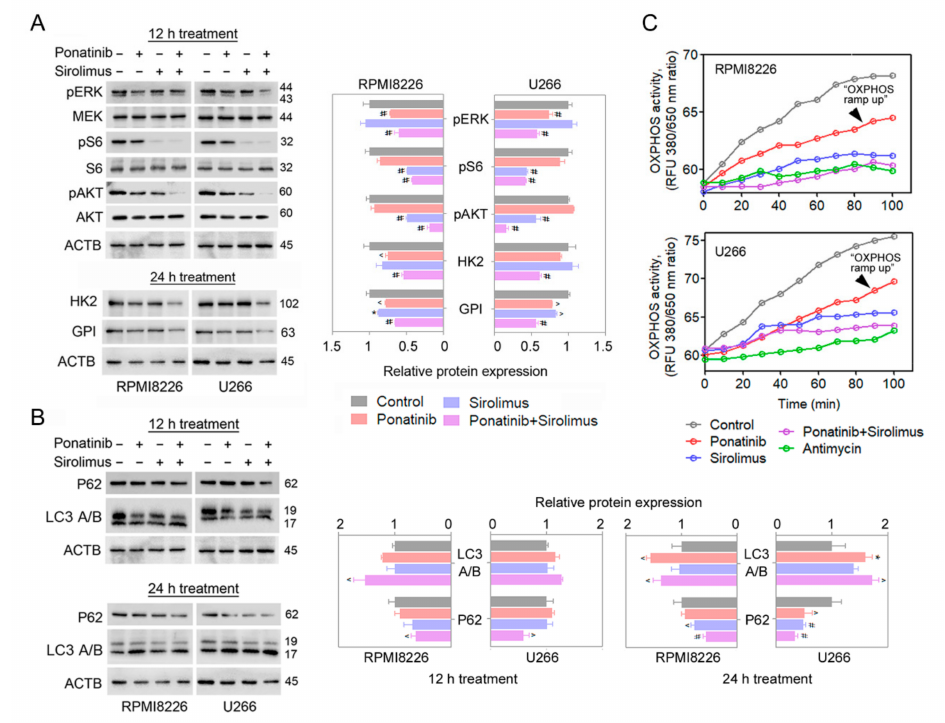
Figure 4. Ponatinib and sirolimus inhibit AKT/mTORC1 pathways and residual oxidative phos- phorylation (OXPHOS) in multiple myeloma cells. ( A ) Ponatinib at 300 nM and/or 150 pM sirolimus was/were administrated to RPMI8226 and U266 cells for 12 or 24 h. The activity of ERK/AKT/mTORC1 pathways was quantified by specific phosphorylated antibodies with Western blot. Expression was quantified by ImageJ and represented as a histogram. HK2 and GPI expression was determined after 24 h of treatment and quantified. ( B ) RPMI8226 and U266 cells were treated with ponatinib, sirolimus, or with their combination for 12 and 24 h. Changes in LC3 A/B and P62 expression were quantified by Western blotting. Expression was quantified by using ImageJ software and plotted as histograms. ( C ) OXPHOS was measured in vitro, using a specific kit after 24 h of treatments; antimycin was used as a positive control for OXPHOS inhibition. Ponatinib and sirolimus doses were 300 nM and 150 pM, respectively. The uncropped Western blots are shown in Supplementary Figures S4 and S5. Data are presented as mean ± SEM; t -test: * p < 0.05, ˆ p < 0.01, and # p <